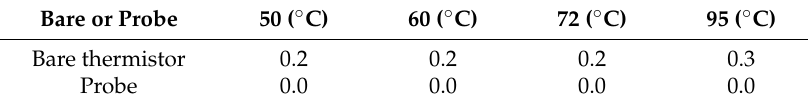
Table 2. Self-heating cancellation for the probe aluminum head radiation (10 k Ω ).